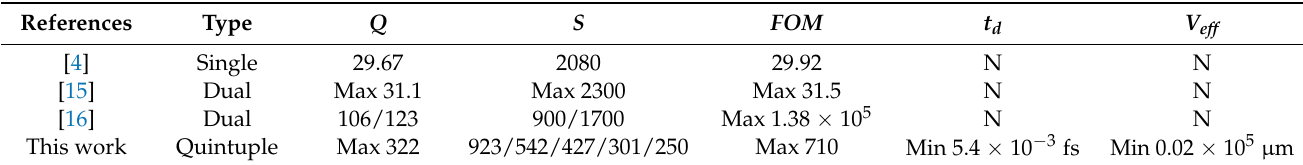
Table 1. Comparison of the proposed structure with the latest relative designs.